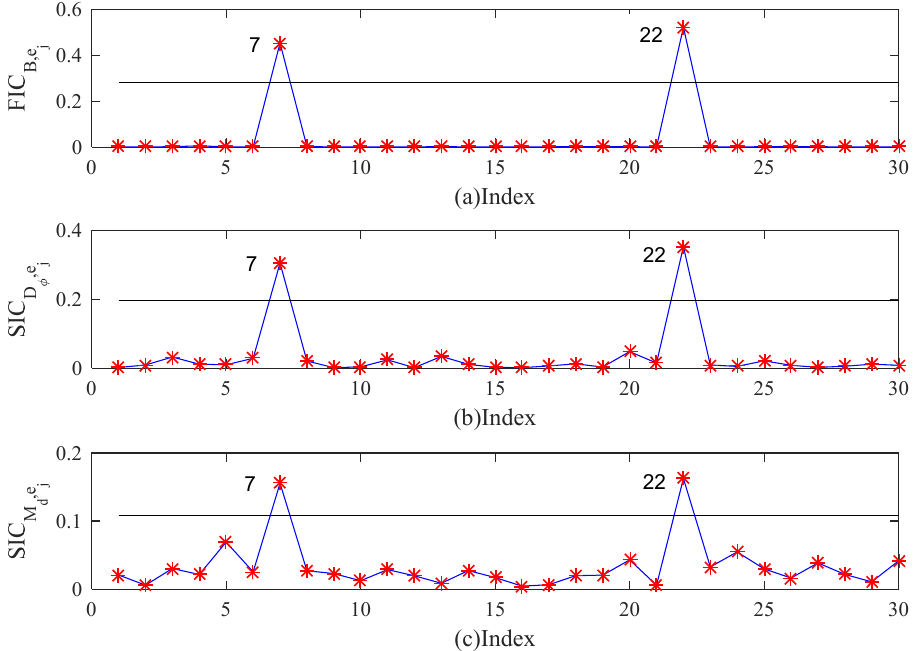
Figure 2. Plots of response variables perturbation in Simulation 1.